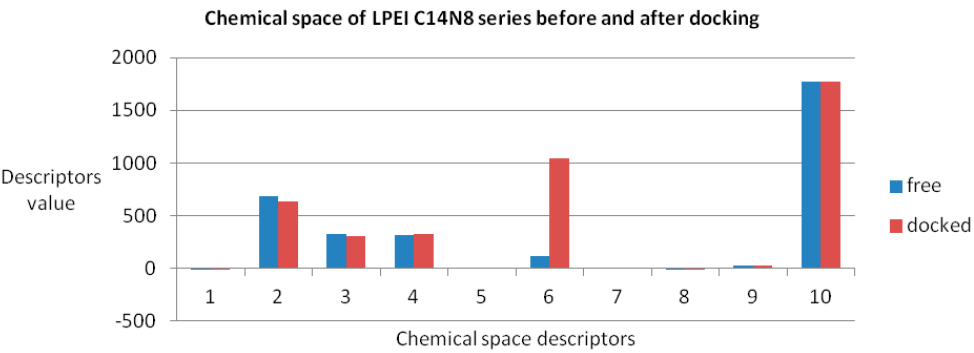
Figure 6. Chemical property space descriptors in C14N8 PEIs, before (free of docking) and after docking.